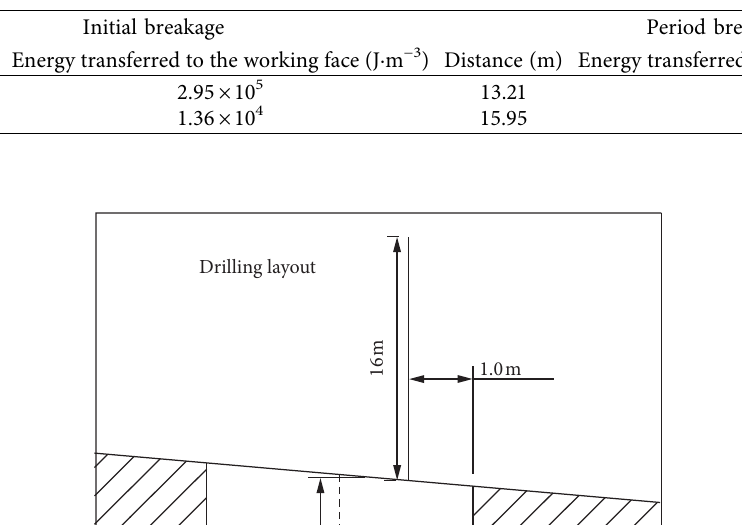
Figure 4: Construction of precise prevention and control system for the source of rock burst in Xin’an mine. Table 1: Calculation of the energy transfer from the roof rock to the working face.